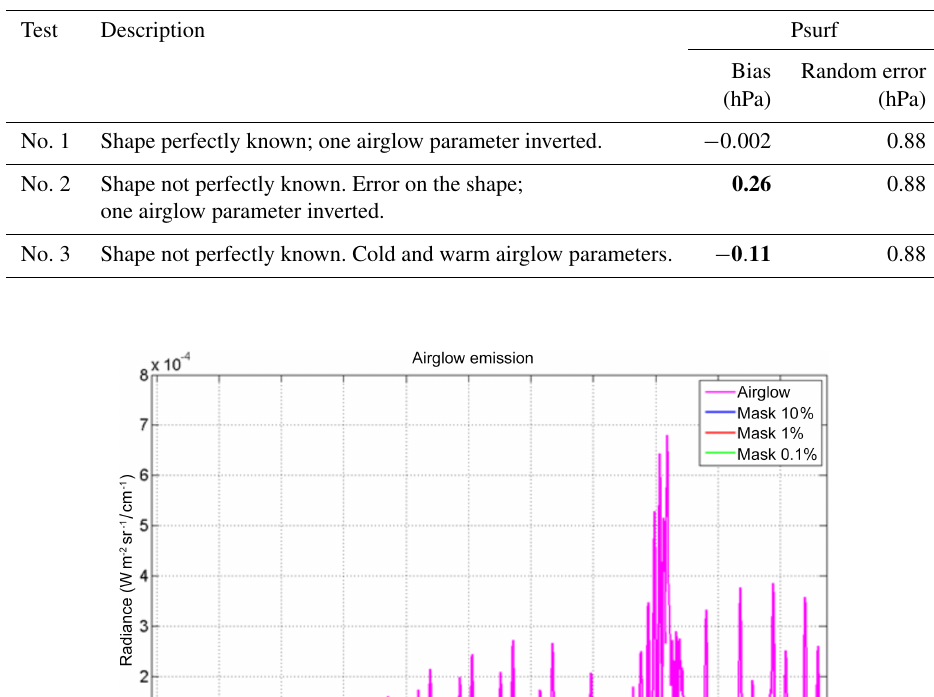
Table D1. Results of the Psurf inversion by method no. 1 (airglow also inverted). Values printed in bold are non-compliant with Mi- croCarb requirement. Non-bold indicates compliant values.